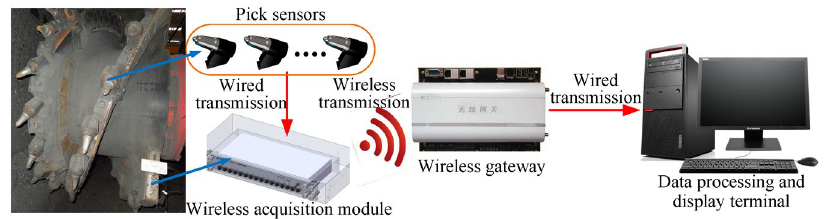
Figure 4. Data acquisition system of picks.